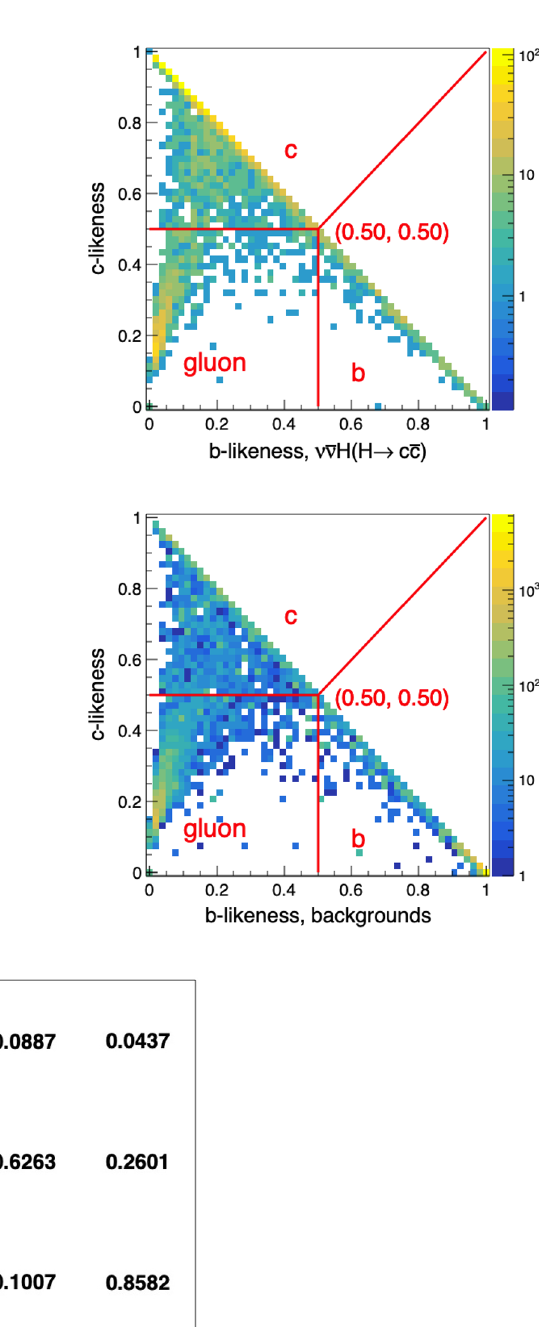
Figure 7 . The distributions of b/c-likeness for ν ¯ νH ( H → b right), ν ¯ νH ( H → gg ) (middle left), and SM backgrounds (middle right). The optimized flavor tagging performance matrix is shown as the bottom plot, where the element represents the flavor identification